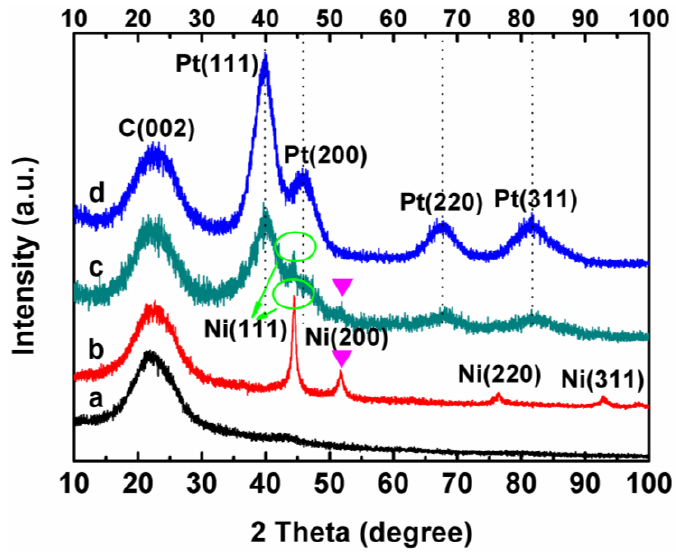
Figure 1. X-ray diffraction patterns of ( a ) Ni the vertical dot lines correspondent to the positions of diffraction peaks for the home-made Pt/C